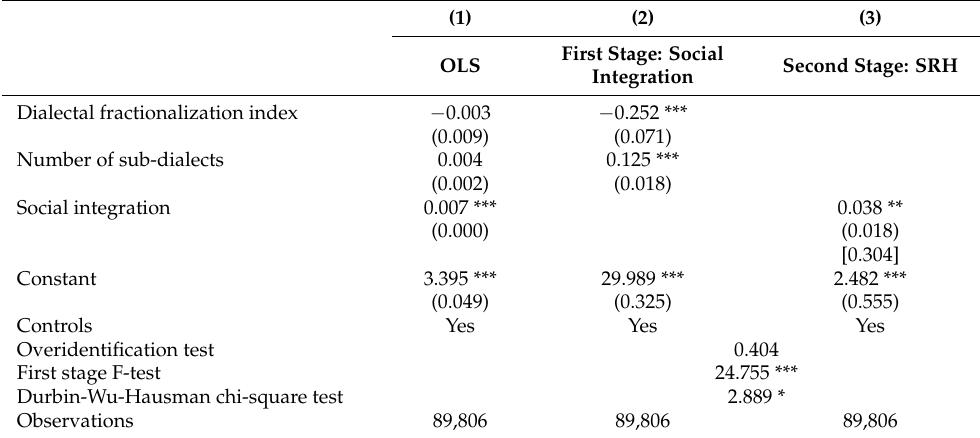
Table 2. Tests for the validity of the two instruments and the IV estimates.